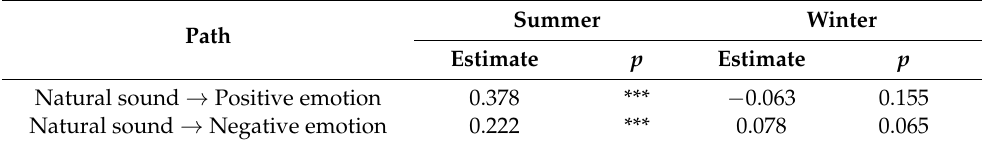
Table 10. Path coefficient difference